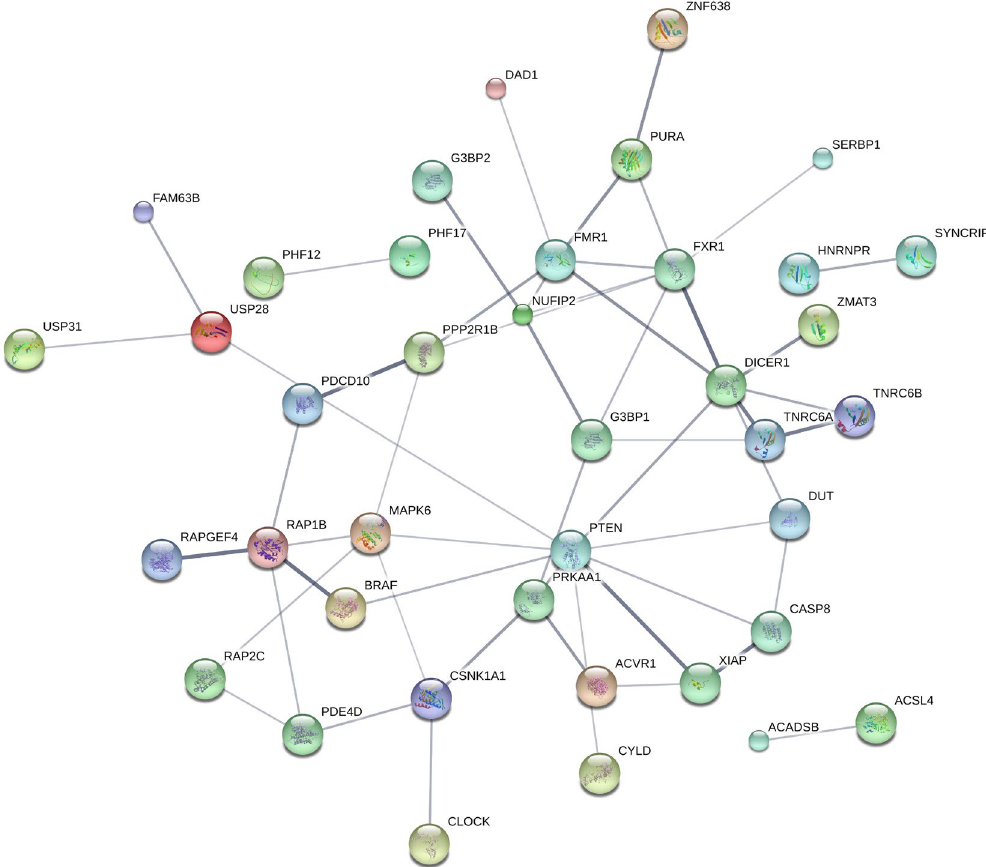
Figure 3. ceRNA network of PTEN. Figure shows the protein-protein interaction (PPI) of PTEN and its top 100 predicted ceRNAs, showing only the connected components of the network. All genes are among the top 100 predicted ceRNAs and genes with PPI connection to at least one other ceRNA or PTEN are depicted. The PPI network is obtained from the STRINGD DB database. The thickness and the darkness of the edge correspond to confidence in the PPI interaction.